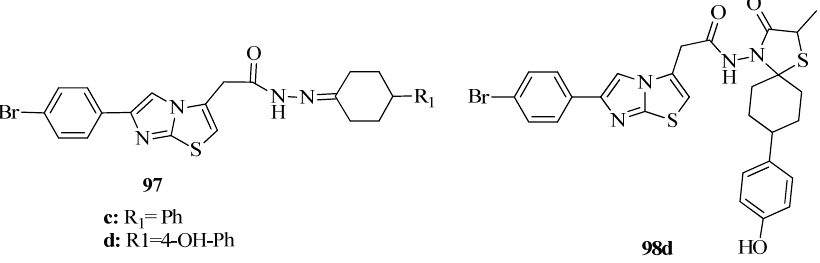
Figure 38. Structures of Imidazo[2,1-b] thiazole derivatives.